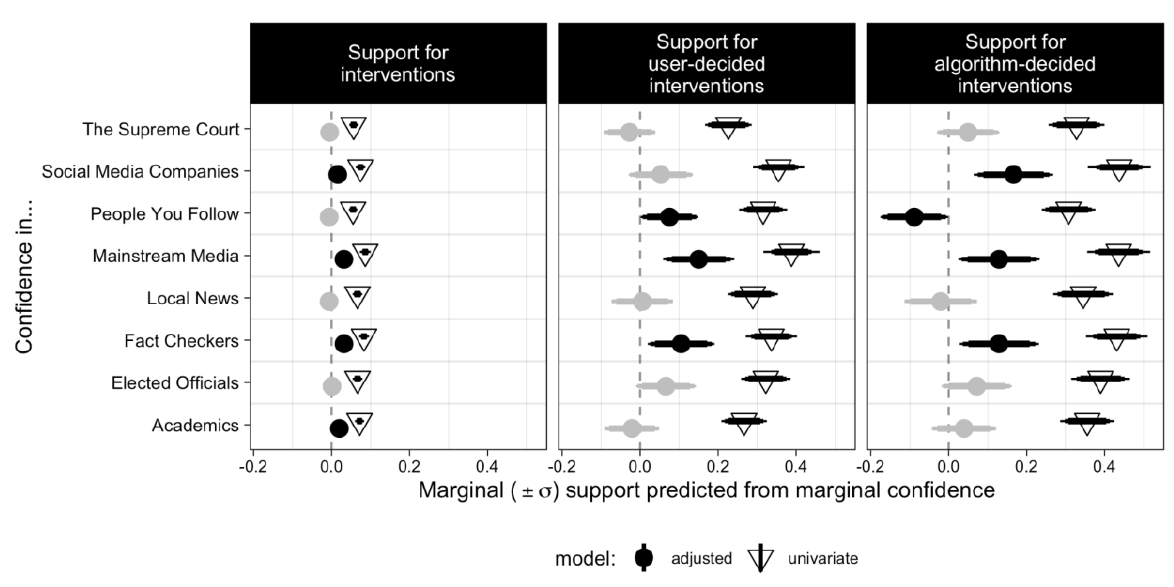
Figure 8. Association between trust in specific social media platforms and support for specific interventions. This grid shows standardized coefficients predicting the increase in support for specific types of interventions (columns) from increases in support for specific institutions (rows), both measured originally on 5-point scales. Each adjusted model controls for the usual covariates as well as confidence in all other institutions besides the one shown. We see that trust effects are highly correlated across the board, though trust in Mainstream Media, Fact Checkers, and Social Media Companies most strongly and robustly predicts increased support.